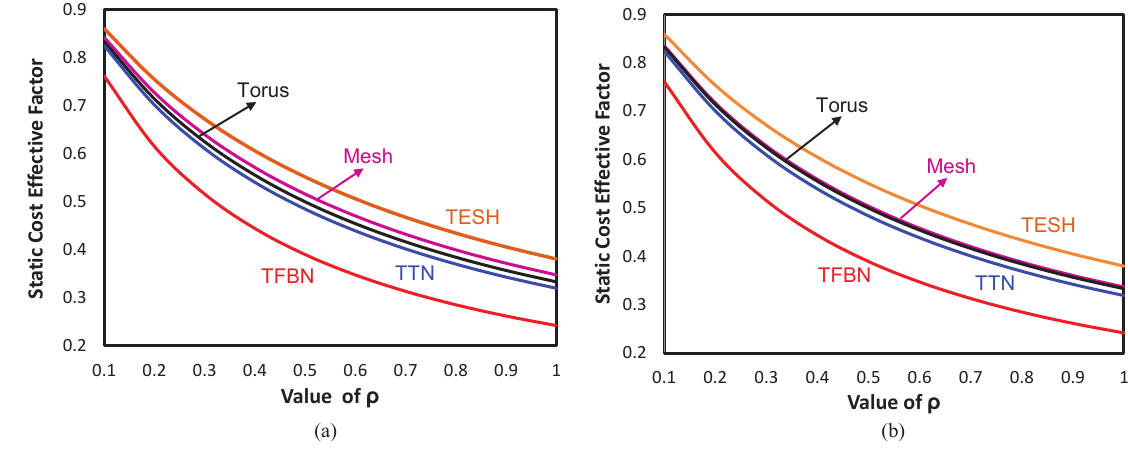
Figure 4. Comparison of static cost-effective factor of various interconnection networks considering different values of ρ ( a ) network size 256 nodes; ( b ) network size 4096